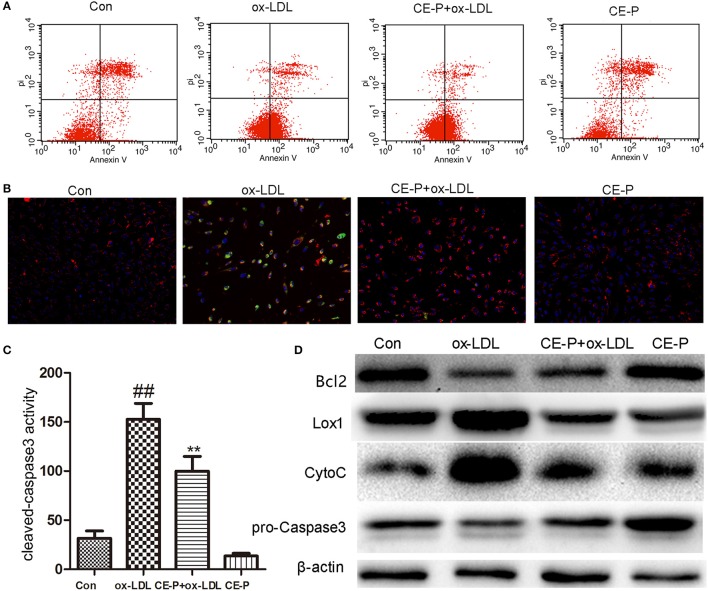
CE-P attenuates the ox-LDL induced HUVECs apoptosis. The protective effect of CE-P on ox-LDL-induced apoptosis was determined via AnnexinV/PI double staining, JC-1 staining, cleaved-caspase3 activity, and western blot assay. HUVECs were pretreated with CE-P (1.25 μg/mL) for 8 h and then incubated with or without ox-LDL for additional 24 h for associated measures. (A) After cell treatment, cell early apoptosis was measured via AnnexinV/PI double staining by flow cytometry. (B) The mitochondria damage during apoptosis was detected by JC-1 staining through fluorescence microscope. (C) At the final stage of apoptosis, the cleaved caspase3 activity was measured by fluorometric assay. (D) Apoptosis associated proteins Bcl2, Caspase3, Cytochrome C were evaluated by western blot. The data are expressed as means ± SD from three independent experiments. ##P < 0.01 vs. control group, **P < 0.01 vs. ox-LDL treatment group.